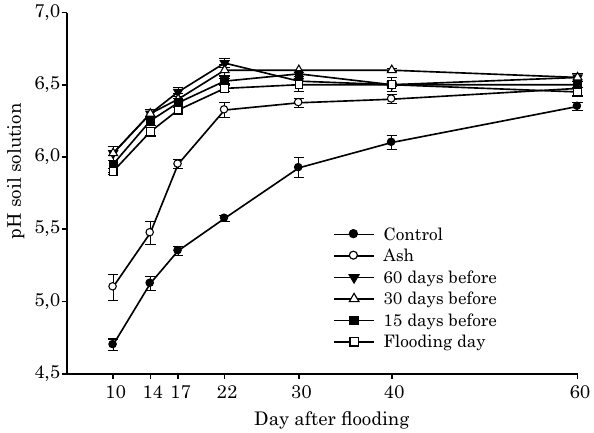
Figure 3. Temporal variation of N-NO 3 - in the soil after flooding as a function of the time of incorporation of rice straw preceding the soil flooding or incorporation of the ash from burned straw. Control: without straw or ash; Ash: ash